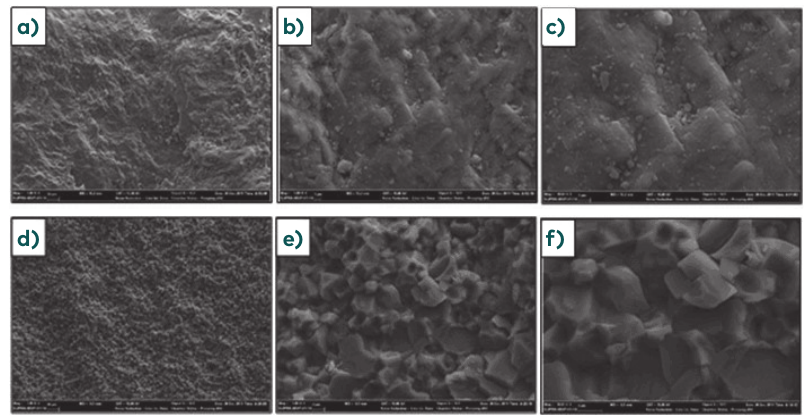
Figure 6. SEM images of materials: a) aggregate SEM image magnification × 1000; b) aggregate SEM image magnification × 5000; c) aggregate SEM image magnification × 10 000; d) marble waste magnification × 1000;